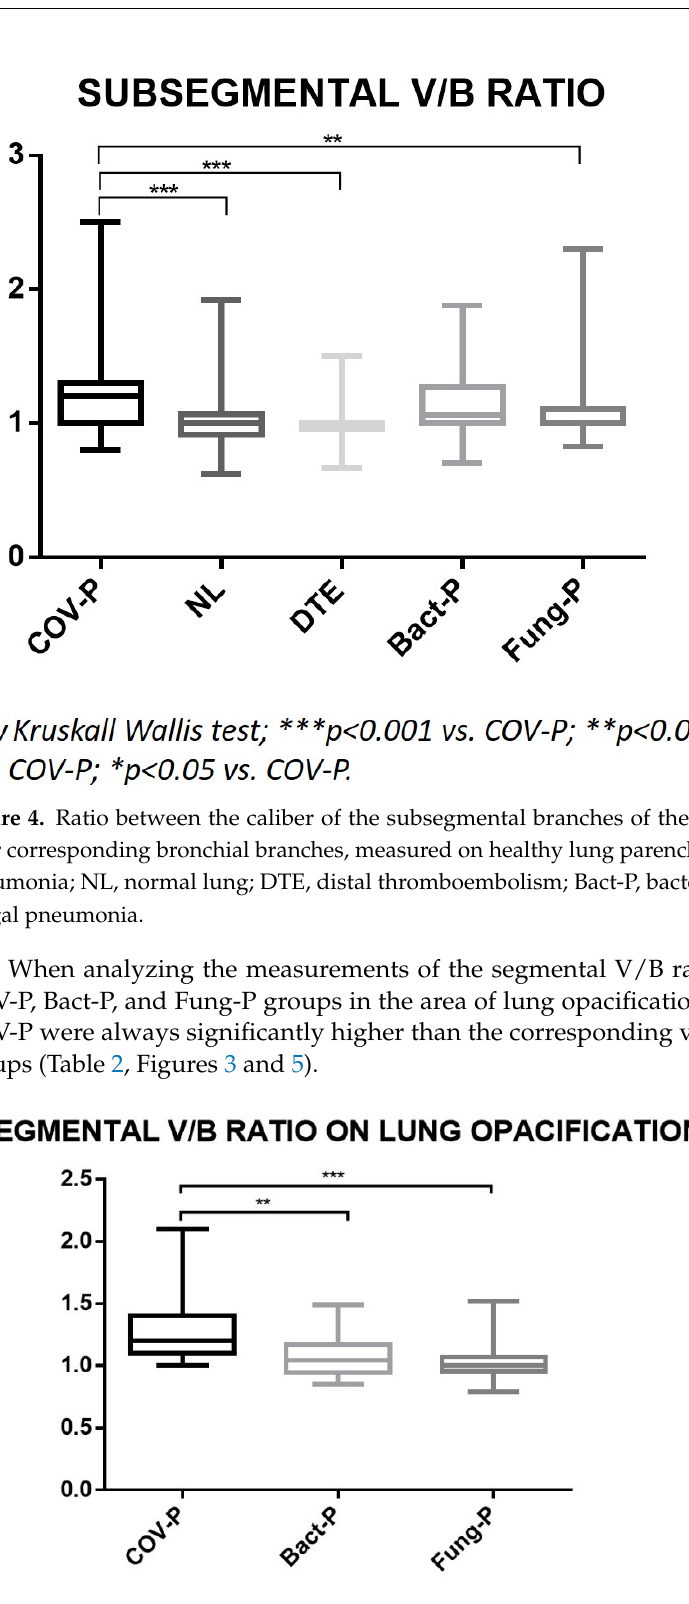
Figure 5. Ratio between the caliber of the segmental branches of the pulmonary arteries and their corresponding bronchial branches, measured on the area of lung opacification. COV-P, COVID-19 pneumonia; Bact-P, bacterial pneumonia; Fung-P, fungal pneumonia.